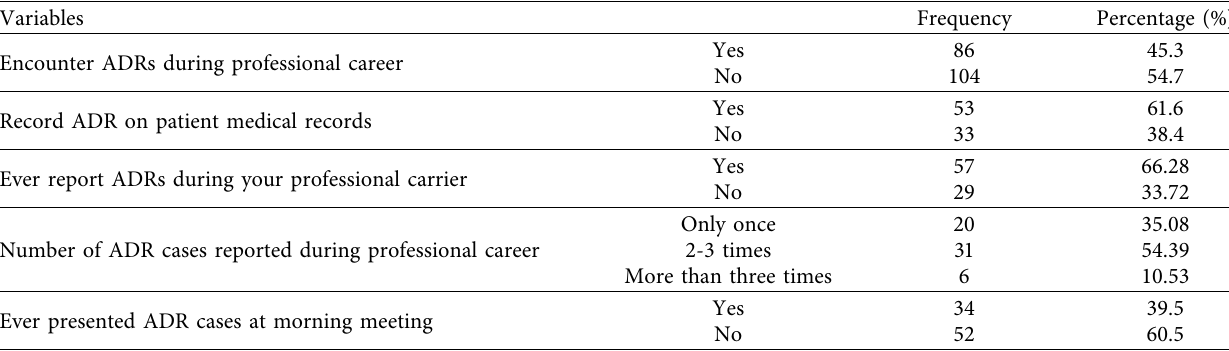
Table 4: Healthcare provider’s practices towards ADR reporting in Mizan Tepi University Teaching Hospital from August to September 2021.